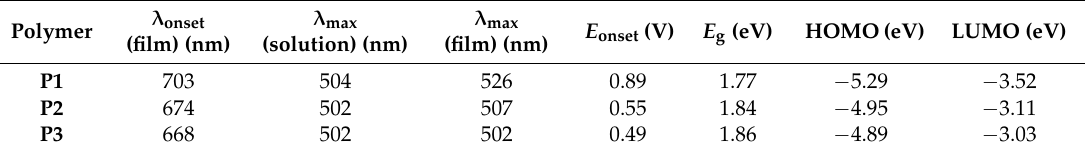
Figure 4. Absorption spectra of three polymers in the form of solutions ( a ) and films ( b ). The inset pictures show the colors of the solutions ( a ) or polymer films ( b ). Table 1. Summary of essential parameters of P1 , P2 , and P3